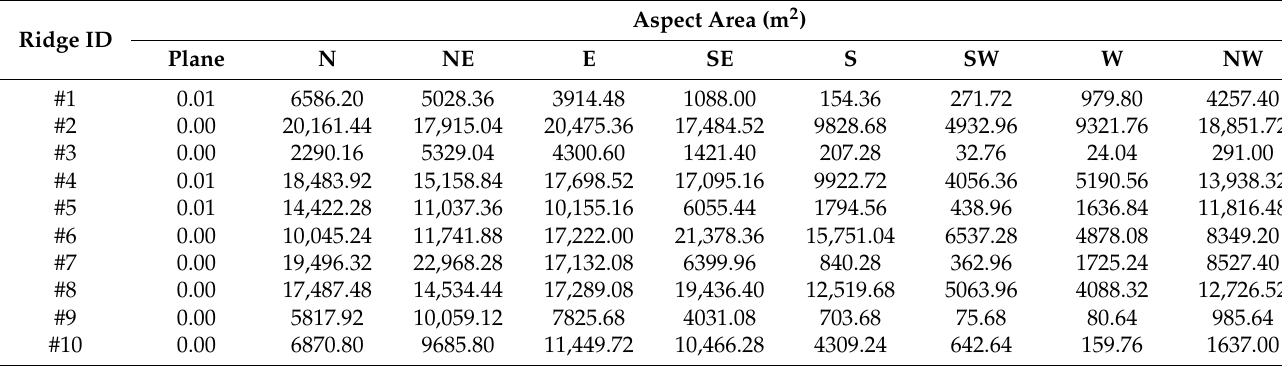
Figure 15. ( a ) Results of the percentage accumulation of inside and outside aspects of the pit rim structure, and ( b ) results of the percentage area of independent ridges’ aspect. Table 9. Statistical results of the aspect areas of independent